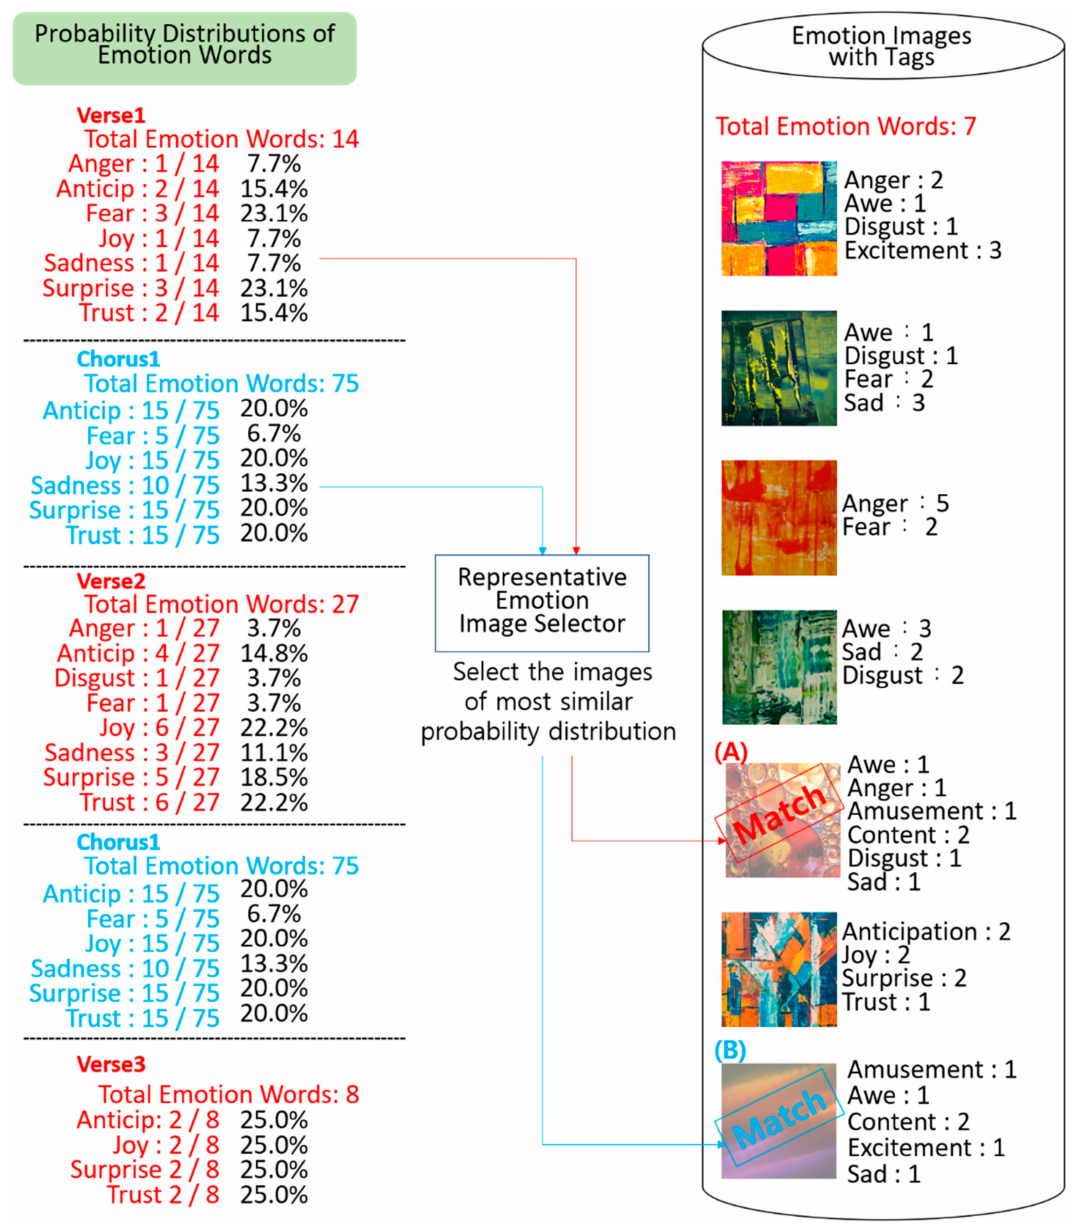
Figure 9. Representative emotion images selector